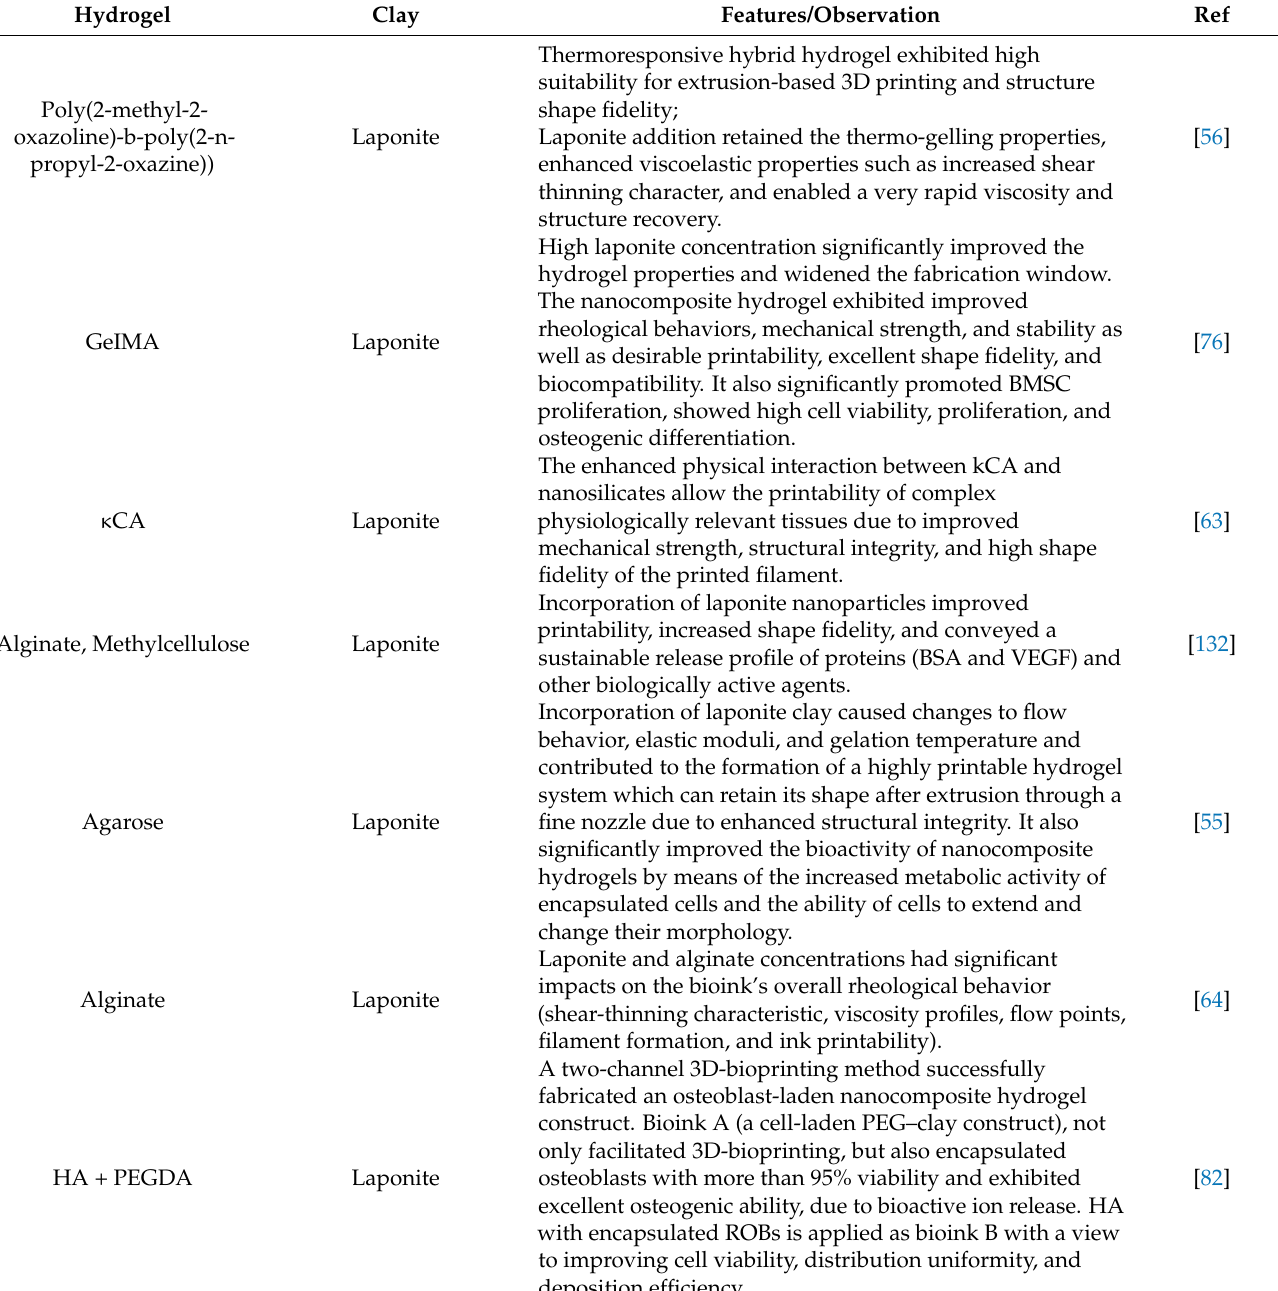
Table 6. Clay nanoparticles in hydrogel nanocomposites used for bioinks and 3D printing.